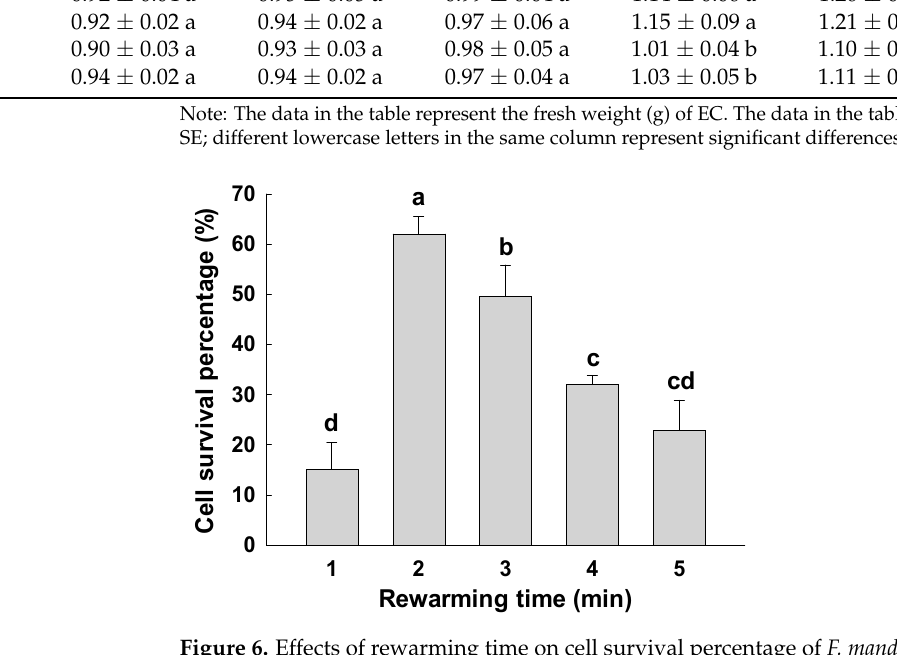
Figure 6. Effects of rewarming time on cell survival percentage of F. mandshurica EC after cryopreservation by vitrification. Note: Different letters are significantly different from each other at p < 0.05, using Duncan’s Multiple Range Test.